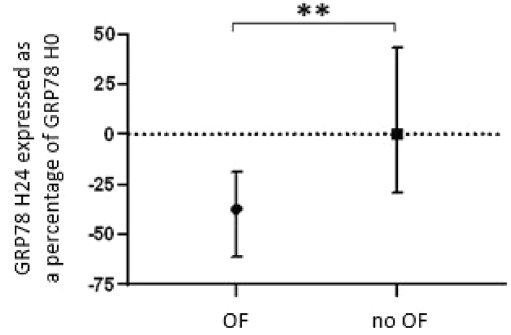
Fig. 1 GRP78 concentration variations from baseline in patients with or without persistent organ failure at 24 h. GRP78: Glucose Related Protein 78 kDa; OF: organ failure; **p <